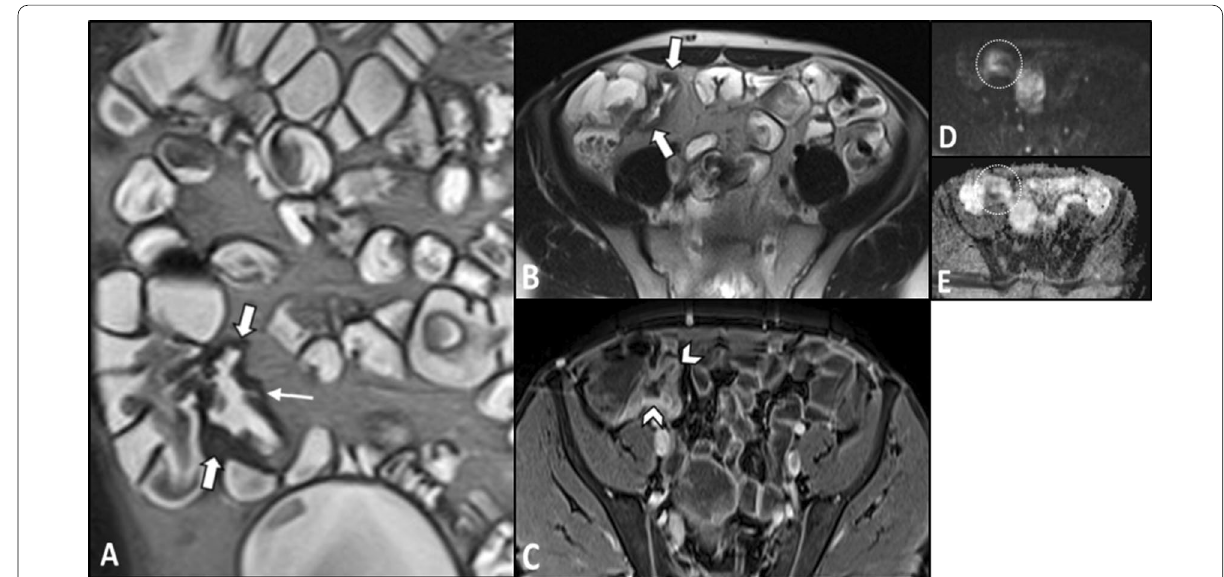
Fig. 12 Terminal ileitis in a 23-year-old female with a history of recurrent oral and genital aphthous ulcers and uveitis presenting with RLQ pain finally diagnosed as Behçet’s disease. MRE was obtained. Coronal and axial T2-W images ( A , B ) show mural thickening in the terminal ileum (thick white arrows) without significant predilection to the mesenteric side in contrast to Crohn’s disease. There is also a deep penetrating ulcer (thin